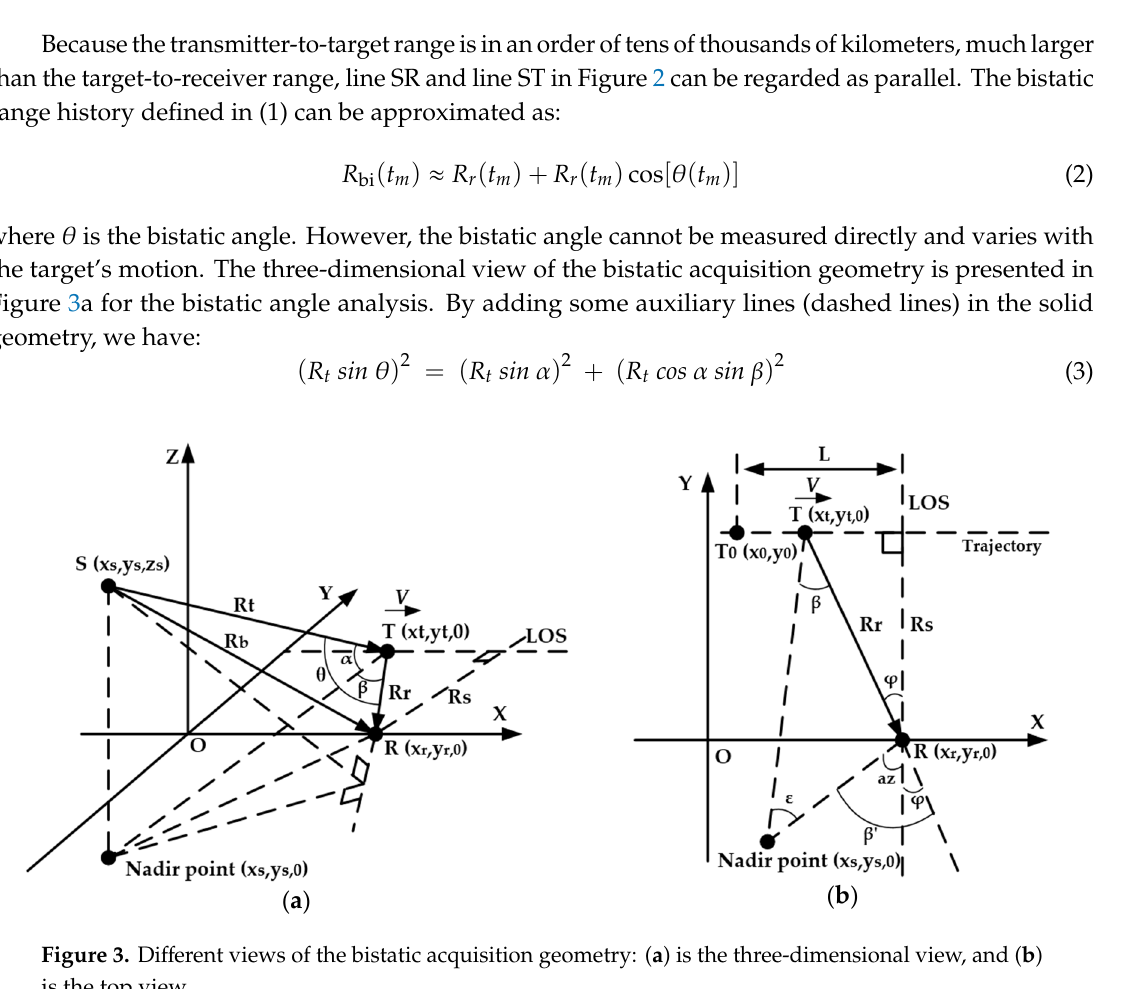
Table 1. Parameters for the real bistatic range and the approximate bistatic range calculation.